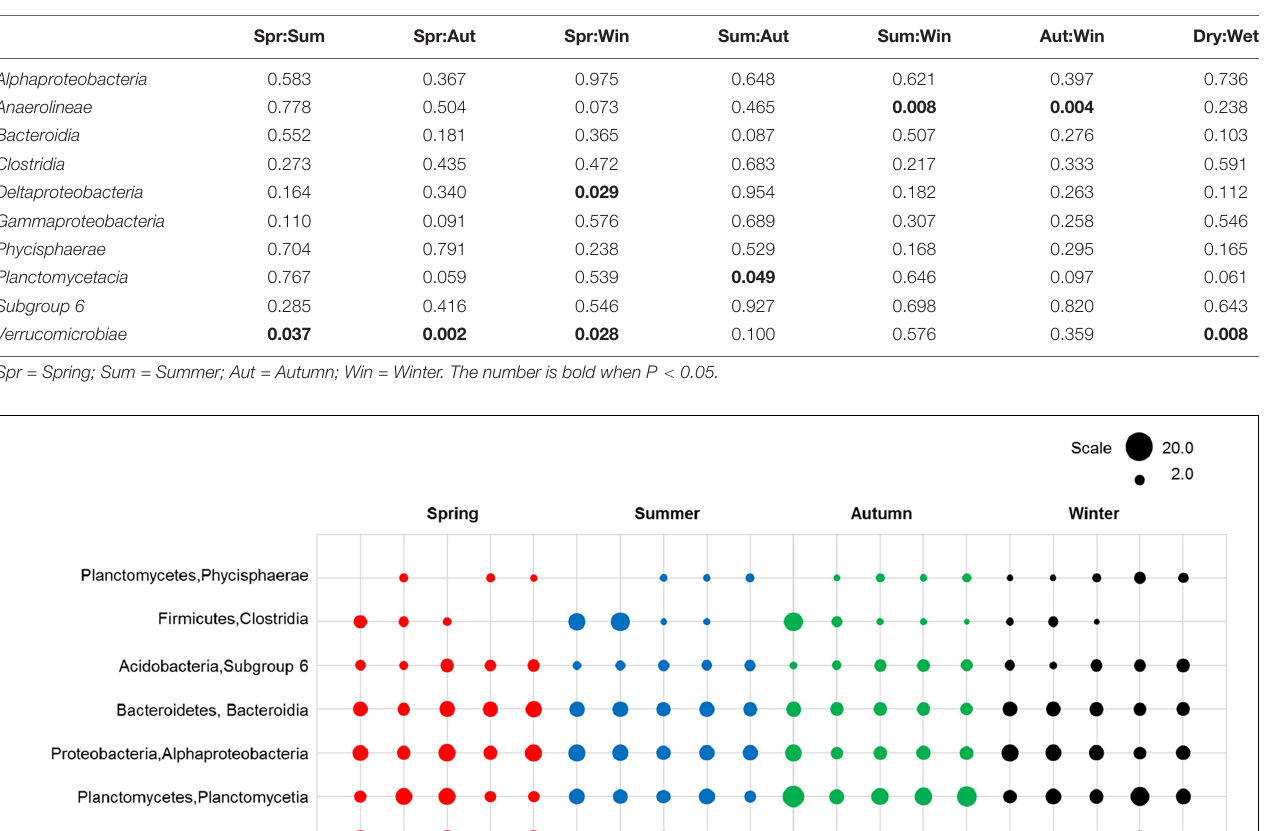
TABLE 5 | Summary of temporal differences in relative abundances of dominant bacterial classes in microbial communities (Welch’s t -test, P < 0.05).